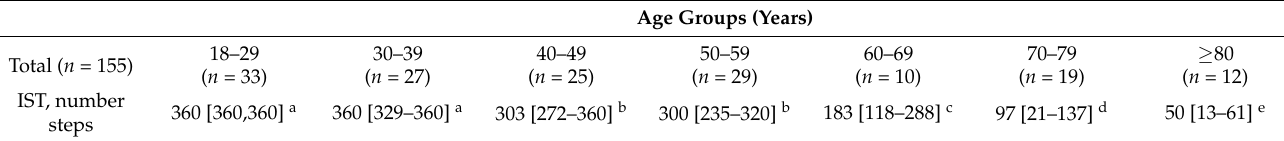
Table 2. Median values of performances on the incremental step test by age decade.